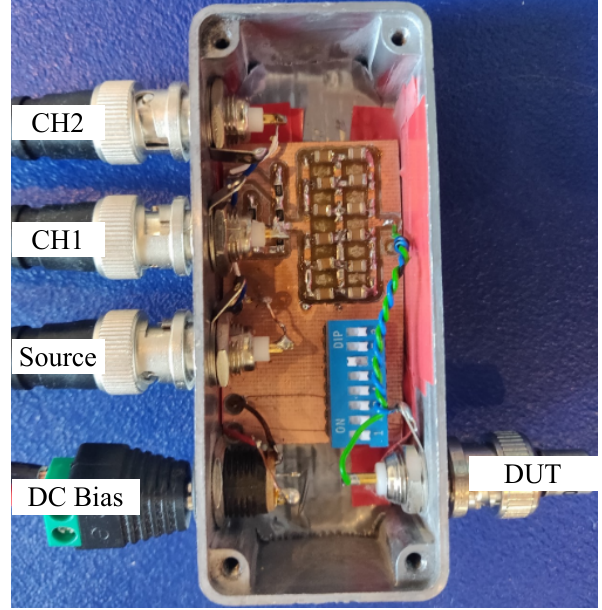
Figure 18. The constructed measurement